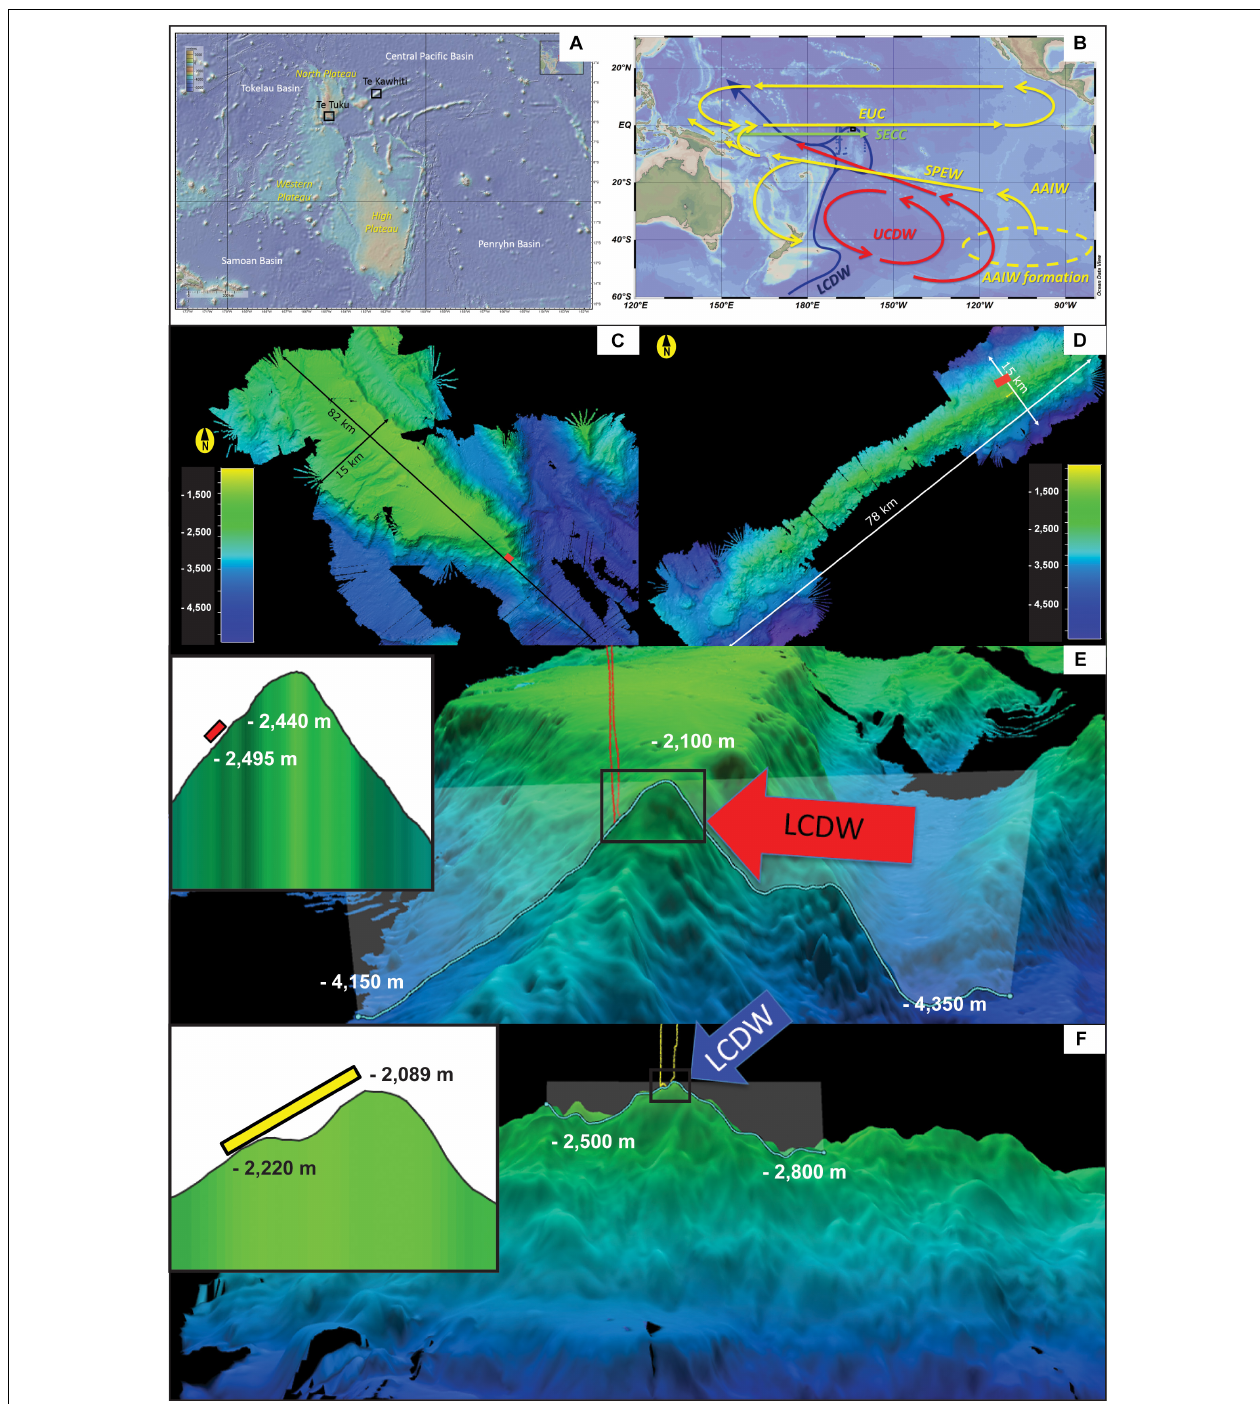
FIGURE 1 | (A) Map of the Northern Manihiki Plateau displaying ROV dives location in black boxes. Plateau regions are labeled in yellow and basins are in white. (B) Map from Ocean Data View showing main circulation patterns and directions (according to Kawabe and Fujio, 2010 and Werner et al., 2013) are displayed with green arrows ( < 1,000 m water depth) yellow arrows (1,000–1,500 m water depth), red arrows (1,500–3,000 m water depth), and blue arrows (bottom water, > 3,000 m water depth). Yellow oval indicates the AAIW formation region. Water masses in the area are AAIW, Antarctic Intermediate Water; UCDW, Upper Circumpolar Deep Water; LCDW, Lower Circumpolar Deep Water; SPEW, South Pacific Equatorial Water; EUC, Equatorial Undercurrent and SECC: south Equatorial Counter Current (modified from Molina-Kescher et al., 2018). Blue dots represent CTD data available from the World Ocean Database (Boyer et al., 2018). (C) Bathymetry of the “Te Tuku” mesa. (D) Bathymetry of the “Te Kawhiti” ridges. (E) Cross-section of the mesa at “Te Tuku” with dive transect (black box) and LCDW direction (red arrow). (F) Cross-section of seamounts summit at Te Kahwiti with dive transect marked in black box LCDW direction (blue arrow).